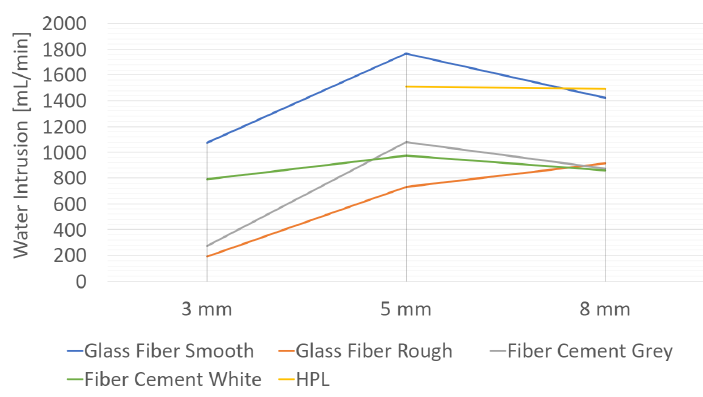
Figure 9. Water intrusion to the interior side of the panels for five different panels with 3, 5, and 8 mm joint